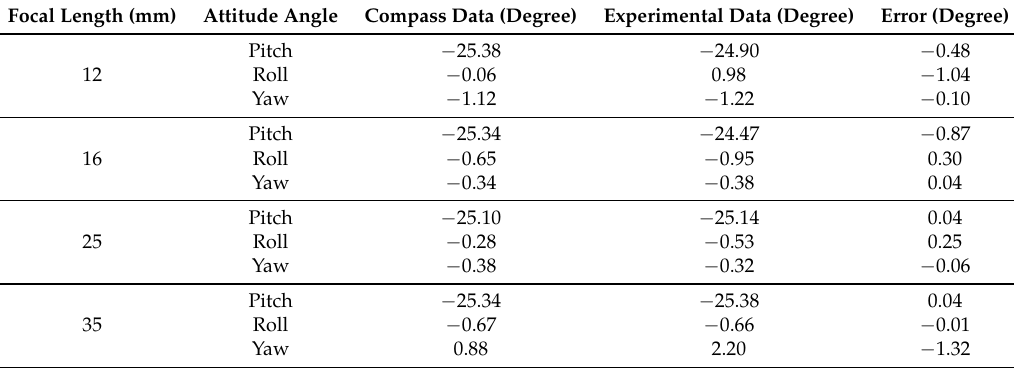
Table 2. Attitude angle at different focal